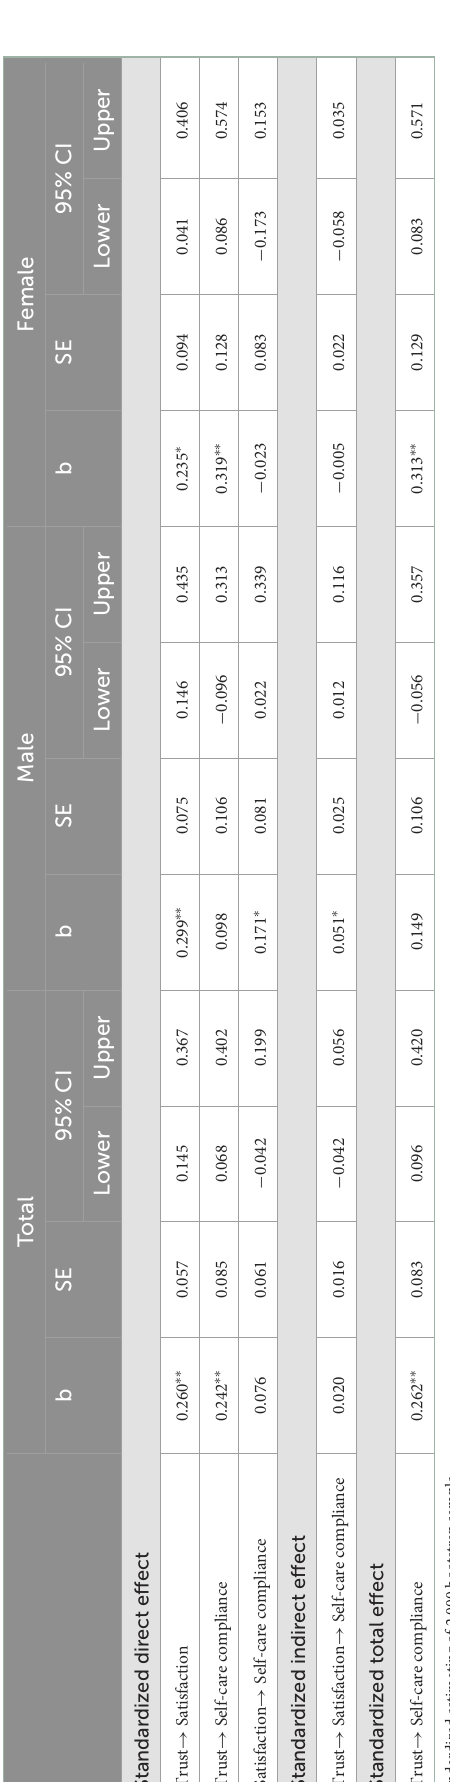
average score of the C-WFPTS is 3.92 ± 0.55. The average scores of the competence and benevolence domains are 3.99 ± 0.57 and 3.85 ± 0.64. The total average scores of satisfaction and CHPS are 3.98 ± 0.61